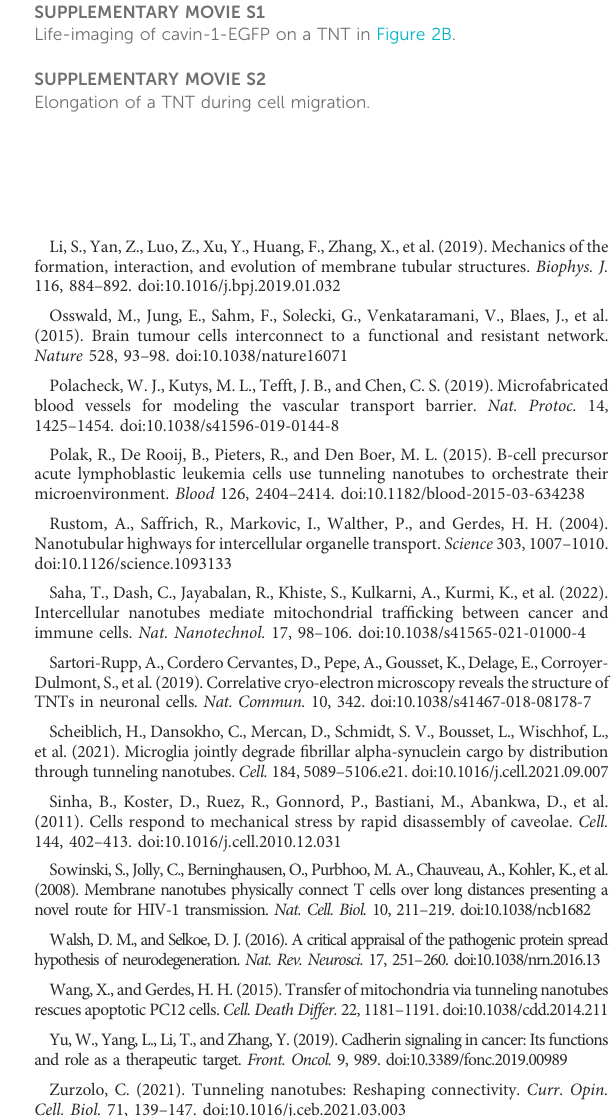
SUPPLEMENTARY FIGURE S1 Distribution of cavin-1-EGFP and glycoprotein on short and long TNTs. (A) Abundance of cavin-1-EGFP on a short and a long TNT (arrows). The relative fl uorescence intensity is the ratio of the fl uorescence intensity of the TNT to that of the TNT-connected cell. (B) Representative images of staining of short and long TNTs with WGA-AF488. Right: relative fl uorescence intensity of WGA-AF488 on the center of TNTs with different lengths. Scale bars, 10 μ m.